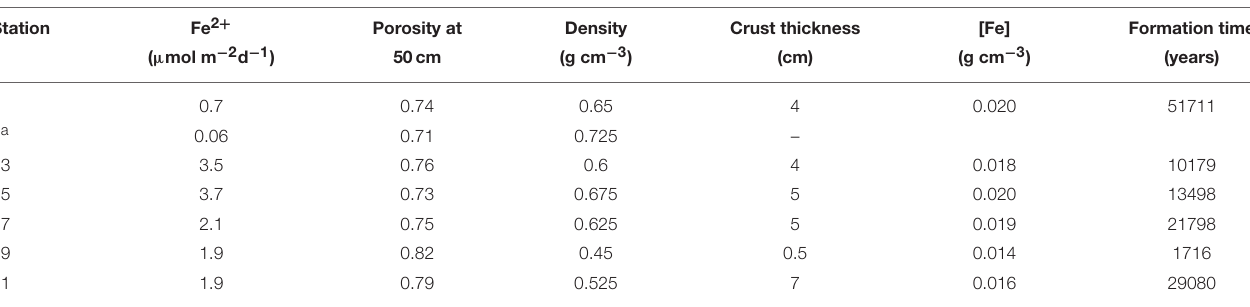
TABLE 6 | Iron crust formation